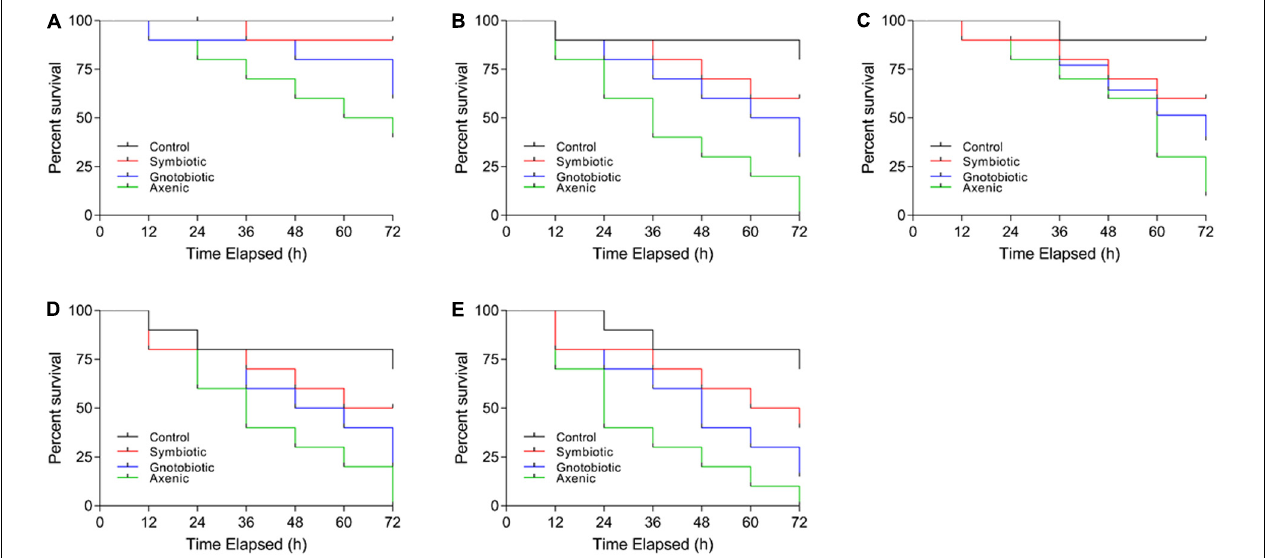
FIGURE 3 | Effect of diet and gut bacterial manipulation on the survival of B. dorsalis larvae after infection: control (A) , P50 (B) , C50 (C) , C20 (D) , and PC50 (E) .